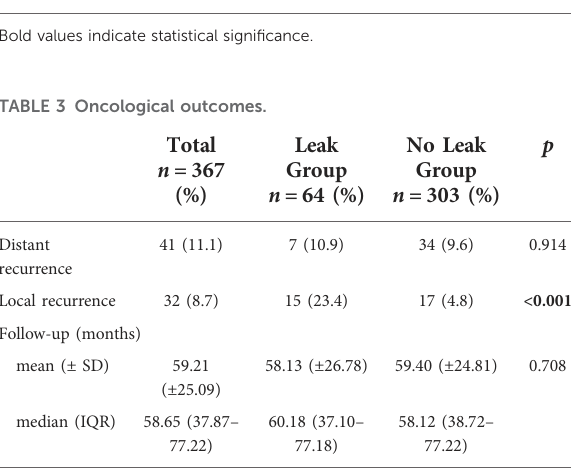
Bold values indicate statistical signi fi